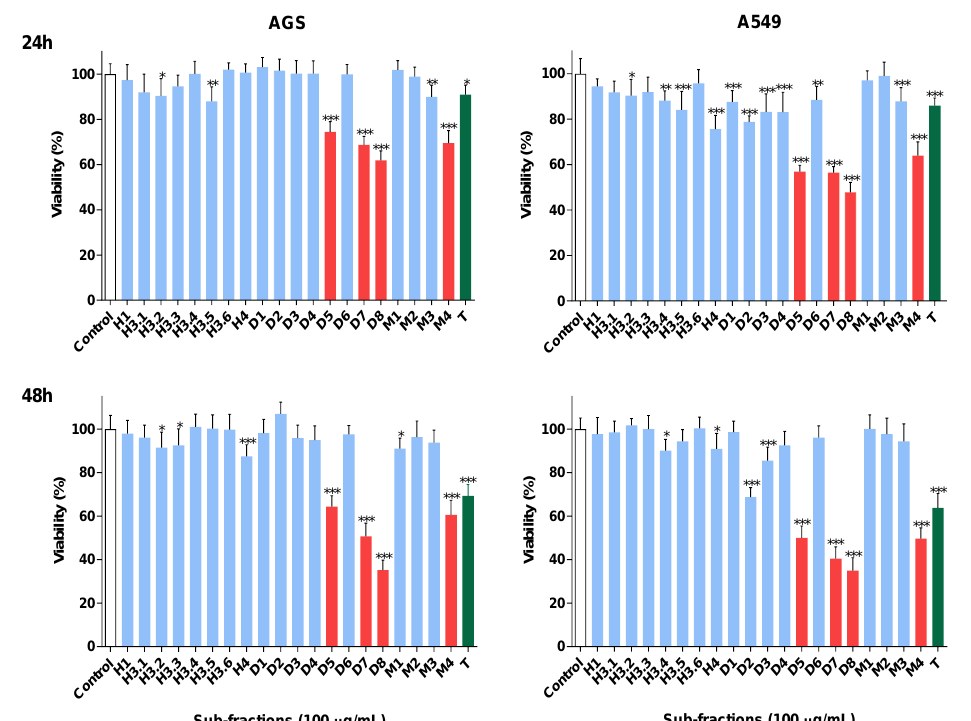
Figure 2. Effect of the sub-fractions (100 µg/mL) on the viability of AGS and A549 cells after 24 h ( top ) and 48 h ( bottom ) of exposure. Topotecan, T (0.5 µM), was used as a positive control for the analysis of cytotoxic effects. Data represent the means ± standard deviation (SD) of at least three